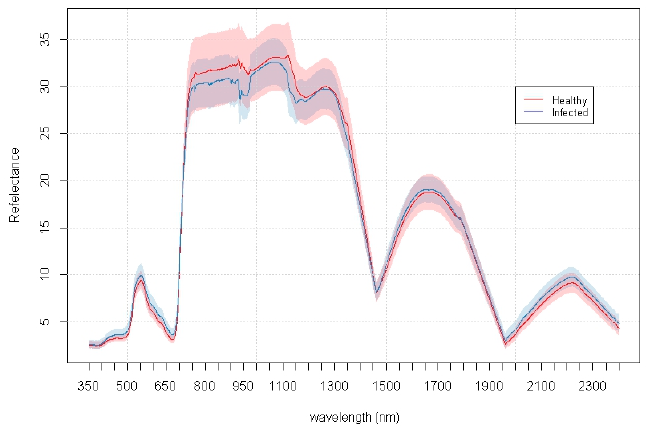
Figure 2. Mean spectral signature of the healthy ( n = 50) and infected ( n = 50) classes. The Healthy (sd) and Infected (sd) signatures represent the 1-sigma standard deviation for the healthy (pink shade) and infected (blue shade) signatures respectively.